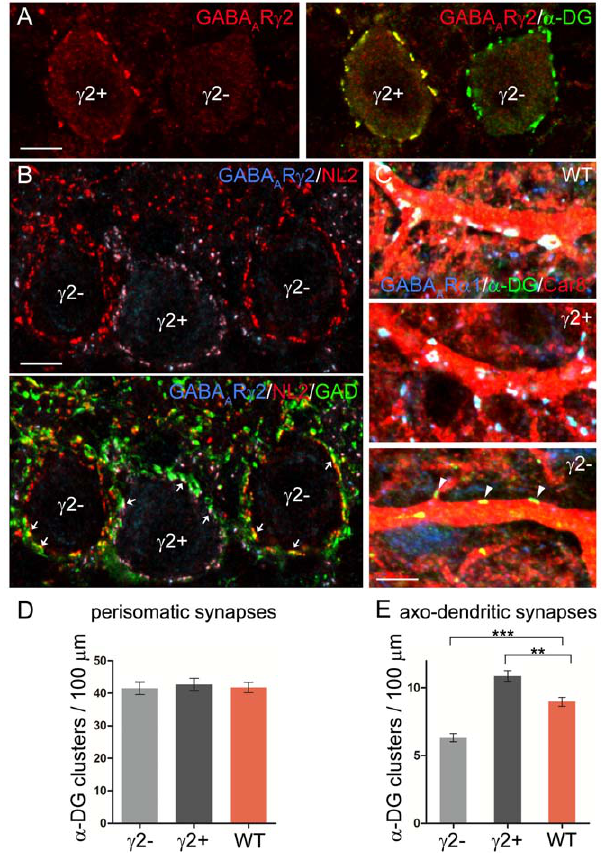
Figure 5. Postsynaptic GABA A Rs determine axo-dendritic but not perisomatic innervations patterns in cerebellar PCs. A, Perisomatic synapses in PCs of a c 2 KD mouse. a -DG (green) co-localizes precisely with the c 2 subunit (red) in a c 2-positive PC ( c 2 + ) and also outlines the profile of a c 2-negative PC ( c 2 2 ). B, Upper panel: NL2 (red) co-localizes precisely with the c 2 subunit (blue) in a c 2-positive PC ( c 2 + ) and also outlines the profile of two c 2-negative PCs ( c 2 2 ). Lower panel: triple labeling shows that NL2 clusters opposite GAD65-positive boutons (green) in both c 2-positive and c 2-negative PCs (arrows). C, Confocal images of PC dendritic profiles after triple labeling for GABA A R a 1 (blue), a -DG (green) and Car8 (red). DG co-localizes with GABA A R clusters in PCs of WT mice as well as in c 2-positive PCs of c 2 KD mice (the superposition of the three fluorescent channels results in white clusters). The lower panel shows a c 2-negative dendritic profile, where a -DG clusters are not associated with GABA A Rs (triangles). D, The density of perisomatic synapses is similar in c 2-positive, c 2-negative and WT PCs ( c 2 + vs c 2 2 , p=0.6920; c 2 + vs WT, p=0.7312; c 2 2 vs WT, p=0.9230; unpaired t -test; n=5 mice per group). E, The density of a - DG clusters is lower in c 2-negative dendrites and higher in c 2-positive dendrites compared with the WT situation (**, p=0.0064, ***, p = 0.0003; unpaired t -test; n = 5 mice per group). Scale bars: A,B=10 m m. C=5 m m.